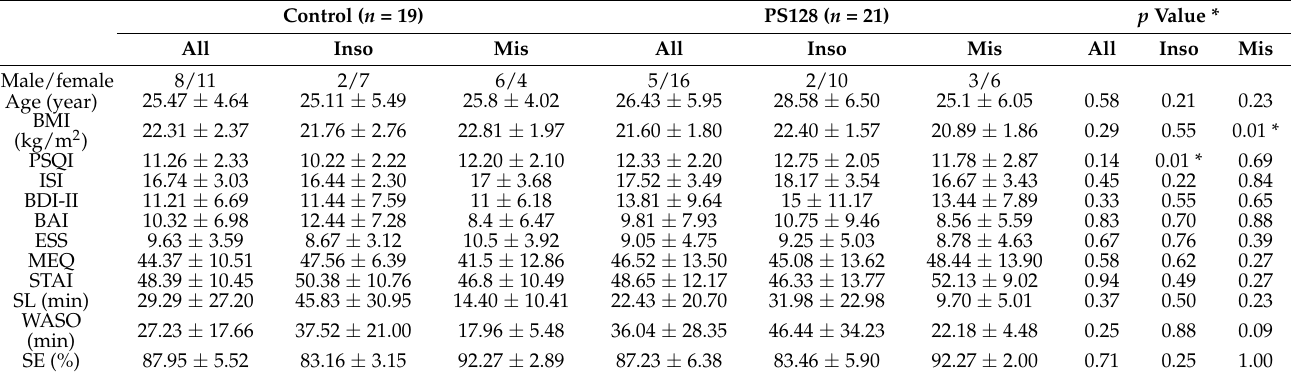
Figure 2. Participant flow: 202 potential participants contacted us. We evaluated participant eligibility using questionnaires, interviews, and sleep dairies. In the end, 40 participants were included. Table 1. Baseline demographic data (mean ±